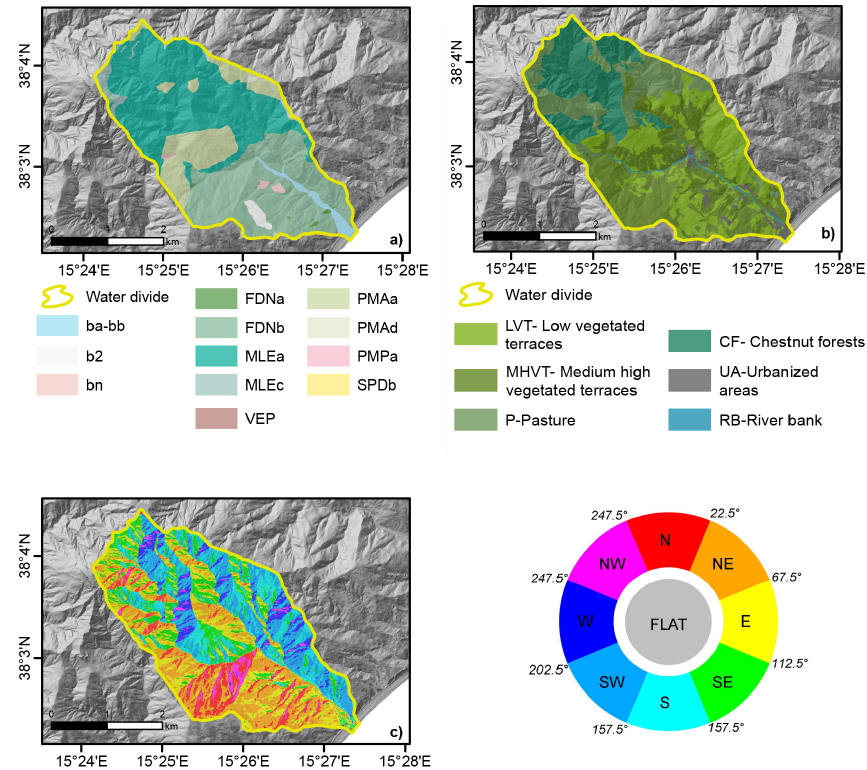
Figure 7. Discrete variables: (a) outcropping lithology (GEO; see Fig. 1 for description); (b) land use (USE); (c) aspect (ASP).